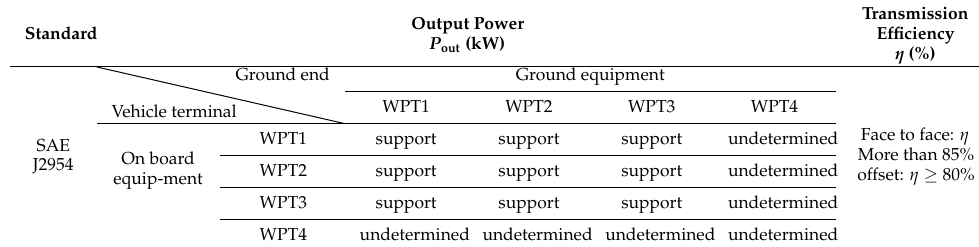
Table 2. Provisions on P out and η in SAE